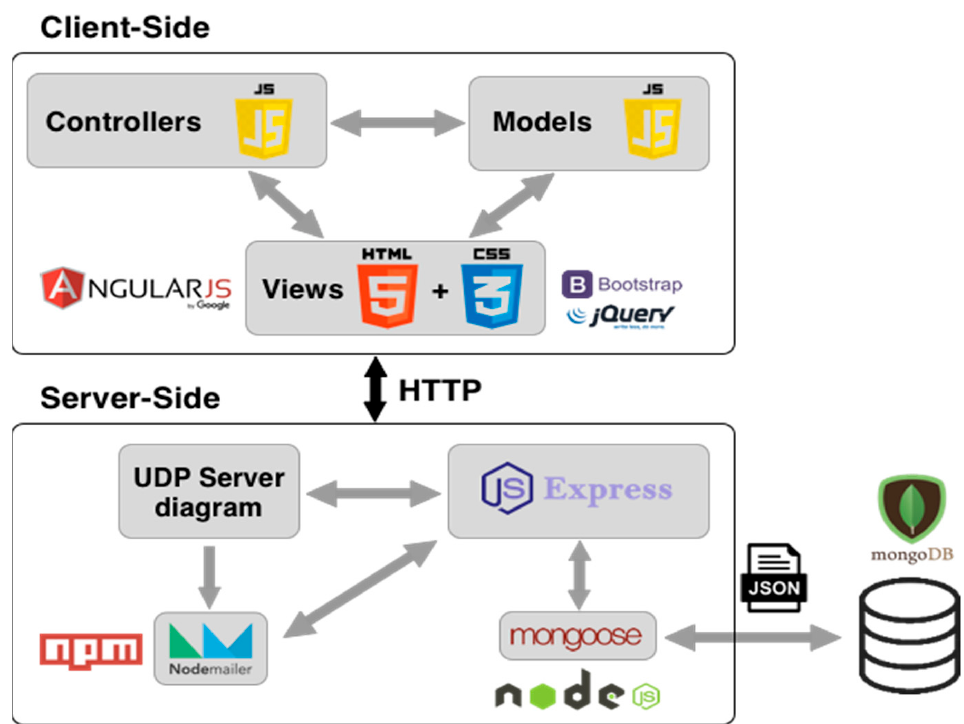
Figure 16. Diagram of the platforms employed in the implemented software solutions.